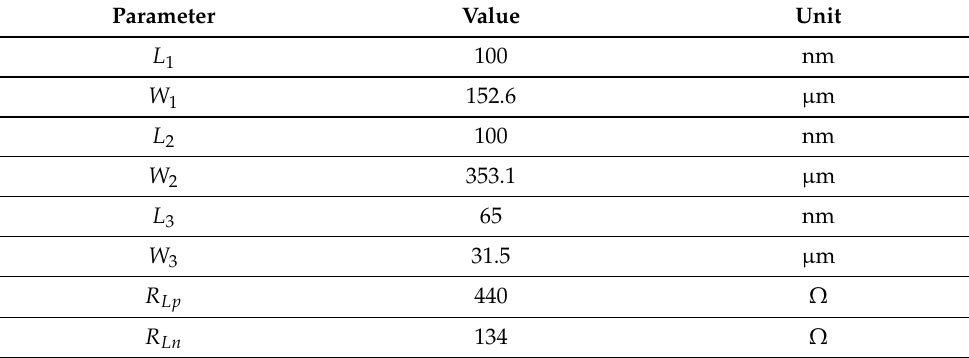
Table 3. Circuit sizing of the first design example.